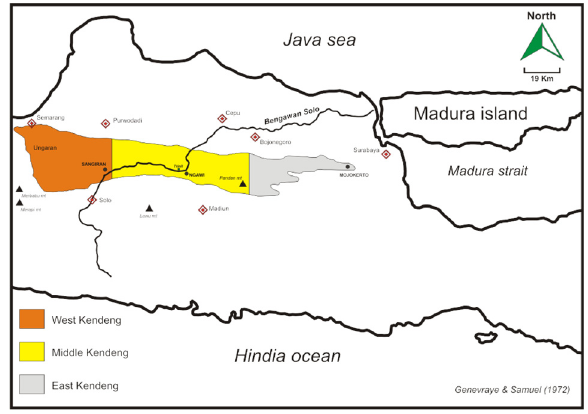
Figure 1. Kendeng Zone and sub-zones: West, Middle, and East Kendengs [2].